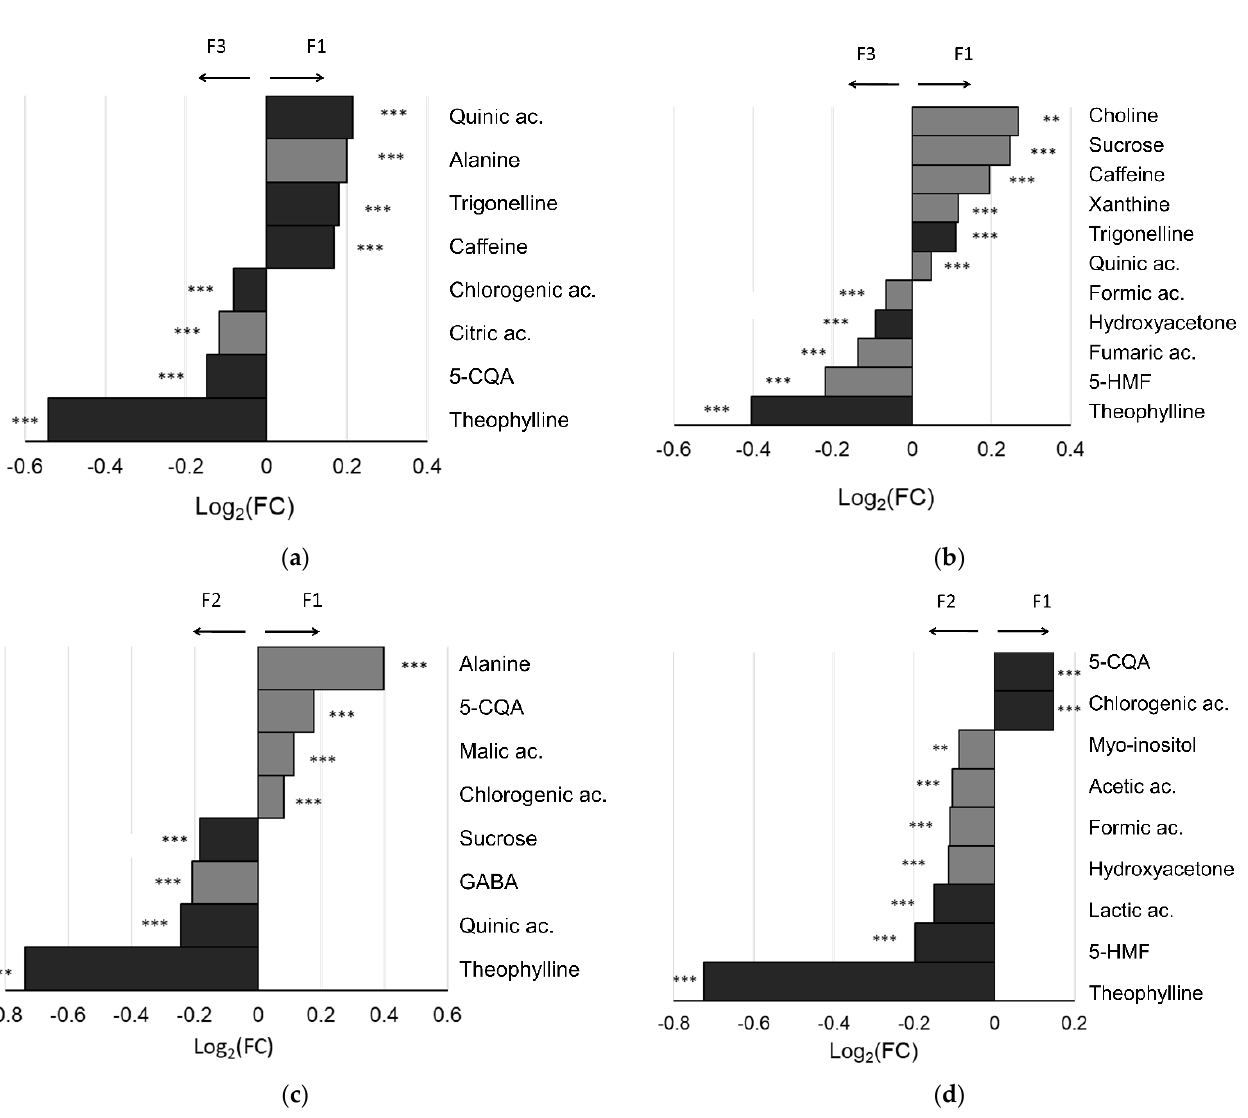
Figure 4. Log 2 (FC) of metabolites’ concentrations characteristic of distinct farms. Positive Log 2 (FC) values represent higher level of green coffee ( a ) and roasted coffee ( b ) metabolites in farm 1 compared to farm 3 (negative Log 2 (FC) values) considering catuai rojo batches; positive values represent higher levels of green coffee ( c ) and roasted coffee ( d ) metabolites in farm 1 compared to farm 2 (negative Log 2 (FC) values) considering bourbon batches. Dark gray bars represent the metabolites which are statistically significant after the FDR p -value correction (FDR < 0.05), gray bars for those metabolites that show a p -value < 0.05 but lose significance after the False Discovery Rate correction. Asterisks represent the Cliff’s delta effect-size, were “***” means large effect, “**” medium effect.